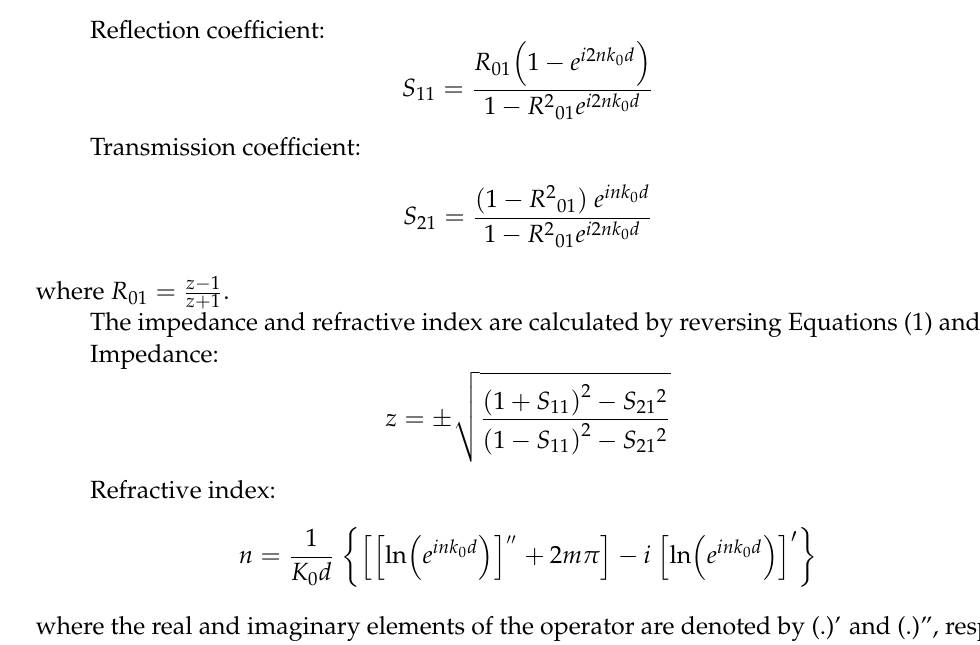
Figure 2. Reflection and transmission coefficients of the proposed MM structure.